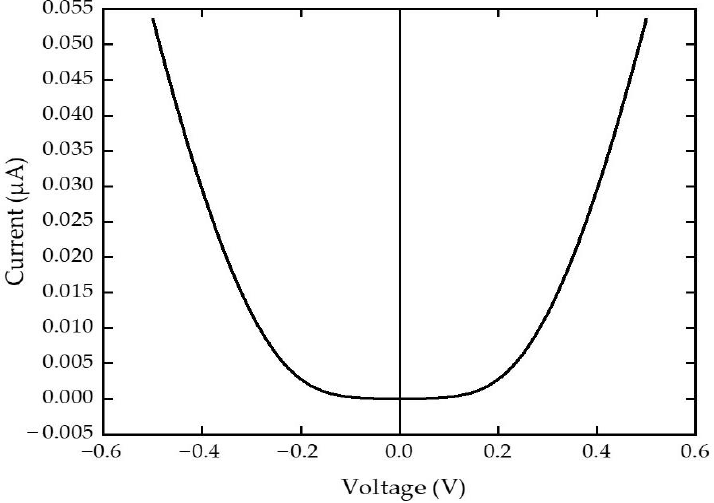
Figure 7. I-V characteristics of the SSD full wave bridge rectifier.